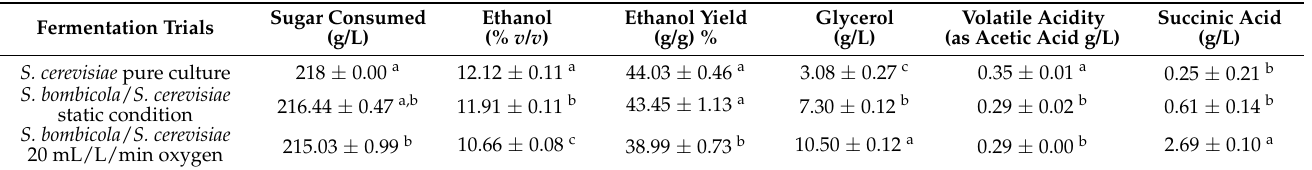
Table 1. Main parameters of NGJ fermentation trials. The initial sugar concentration was 218 g/L. Data are means ± standard deviations from three independent experiments. Data with different superscript letters ( a,b,c ) within each Column are different according to Duncan tests(0.05%).